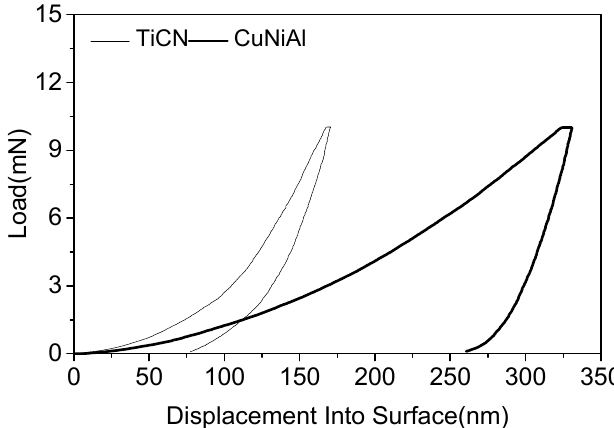
Figure 7. Typical loading–unloading curves of CuNiAl and TiCN coating.